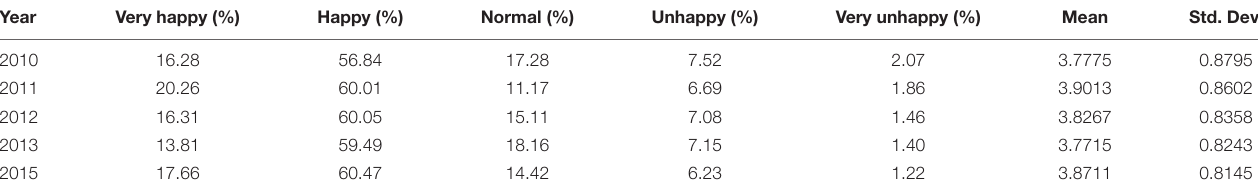
TABLE 1 | Statistical description of happiness in China. Happy (%) Normal (%) Unhappy (%) Very unhappy (%) Mean Std. Dev.